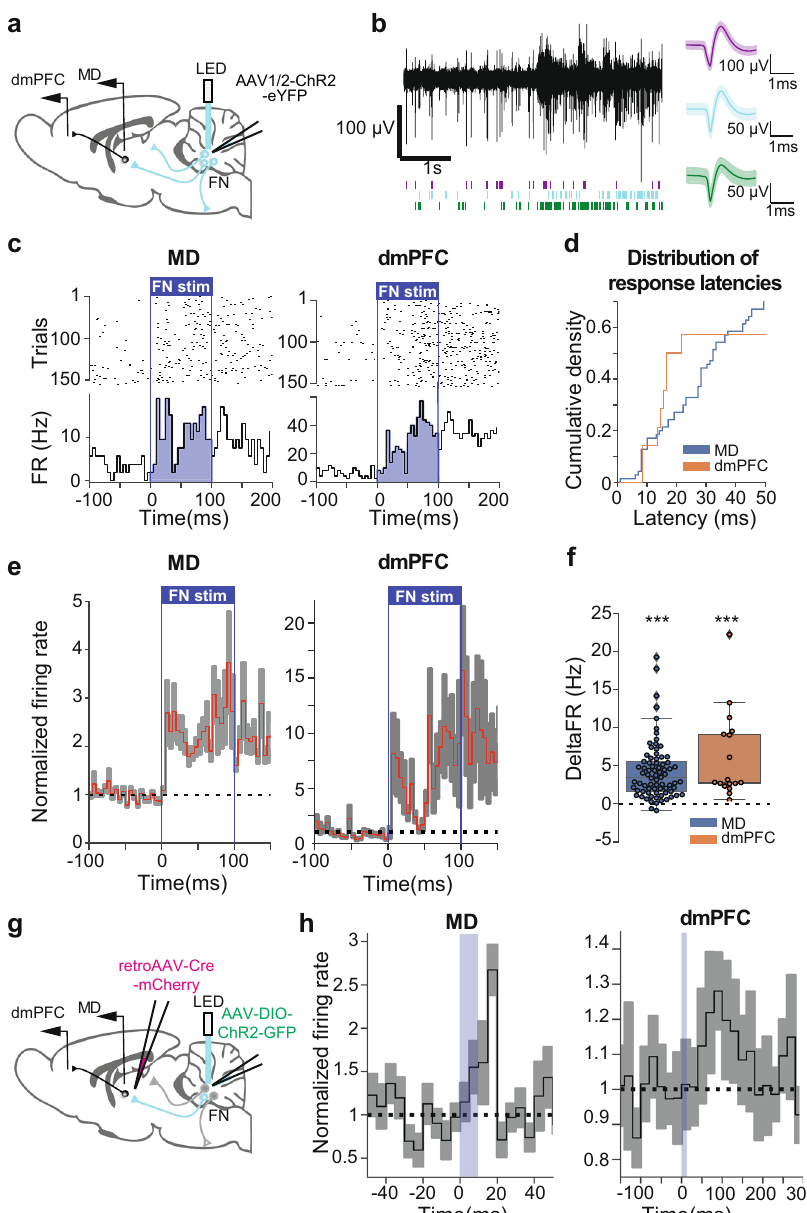
Fig. 3 | Optogenetic stimulation of FN input to MD induced responses in MD and dmPFC. a Strategy used for the speci fi c optogenetic stimulation of FN neu- rons, representing the localinjection of anterograde AAV-ChR2-eYFPintheFNand the implantation of recording electrodes in MD and dmPFC. b Example of high- passed fi ltered trace of a recording channel in MD (left) and spike shapes of single units from MD (average ± SD), after spike sorting (right). c Example PSTH (5ms bins, bottom) and rasterplot (top) of a MD cell (left) and dmPFC cell (right) during 100msoptogeneticstimulationoftheFN.Thelightstimulationisrepresentedbya bluerectangle. d Cumulativehistogramsshowingthelatencyofneuronalresponse of responsive cells in MD and dmPFCtriggered by 100ms optogenetic stimulation oftheFN. e PSTH(5msbins)displayingthechangein fi ringrate(average±SEM)of responsive cells during 100ms optogenetic stimulation of the FN in MD (left), and indmPFC(right).Thelightstimulationisrepresentedbyabluerectangle. f